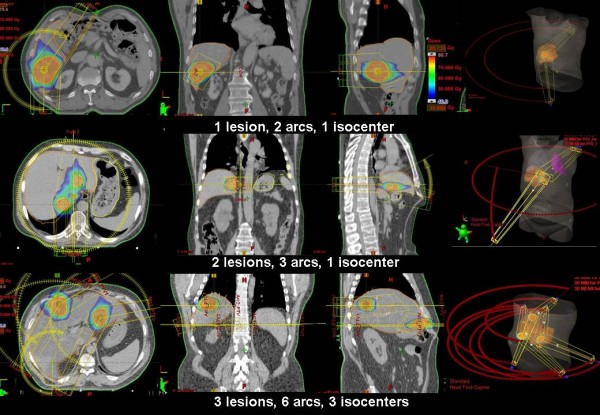
Examples of dose distributions. Colourwash scale is reported on the figure. Solid lines represent target volumes and organs at risk.